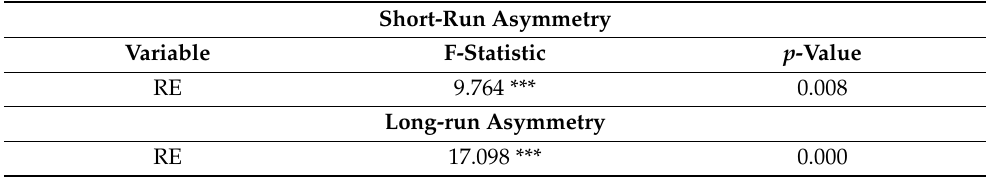
Table 4. Short-run and Long-run Asymmetry